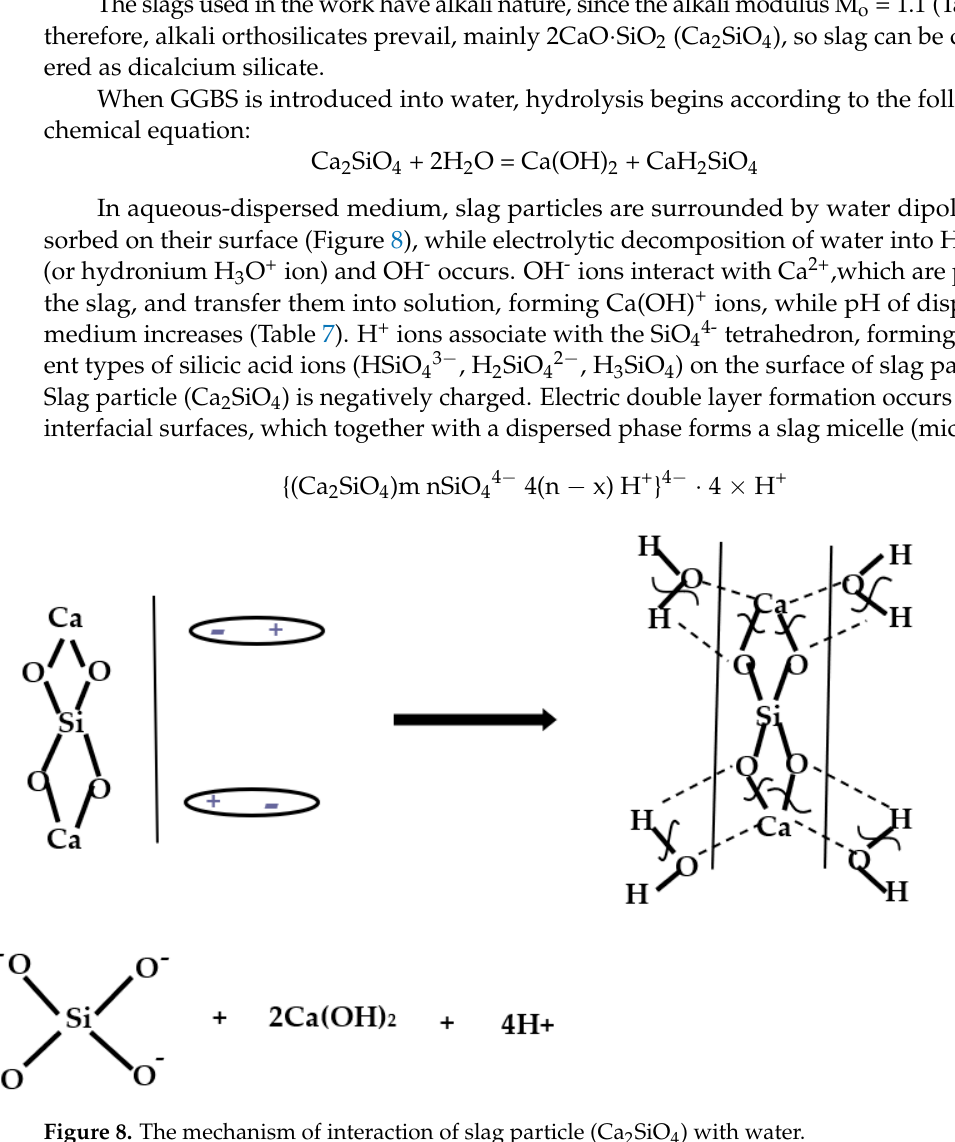
Figure 8. The mechanism of interaction of slag particle (Ca 2 SiO 4 ) with water. Table 7. pH of the dispersed medium in the “slag-water” system. pH of Dispersed Media in Slag Suspensions Period of pH Slag Concentration, Measurement g/L Without Ultrasonic Treatment After Ultrasonic Treatment -